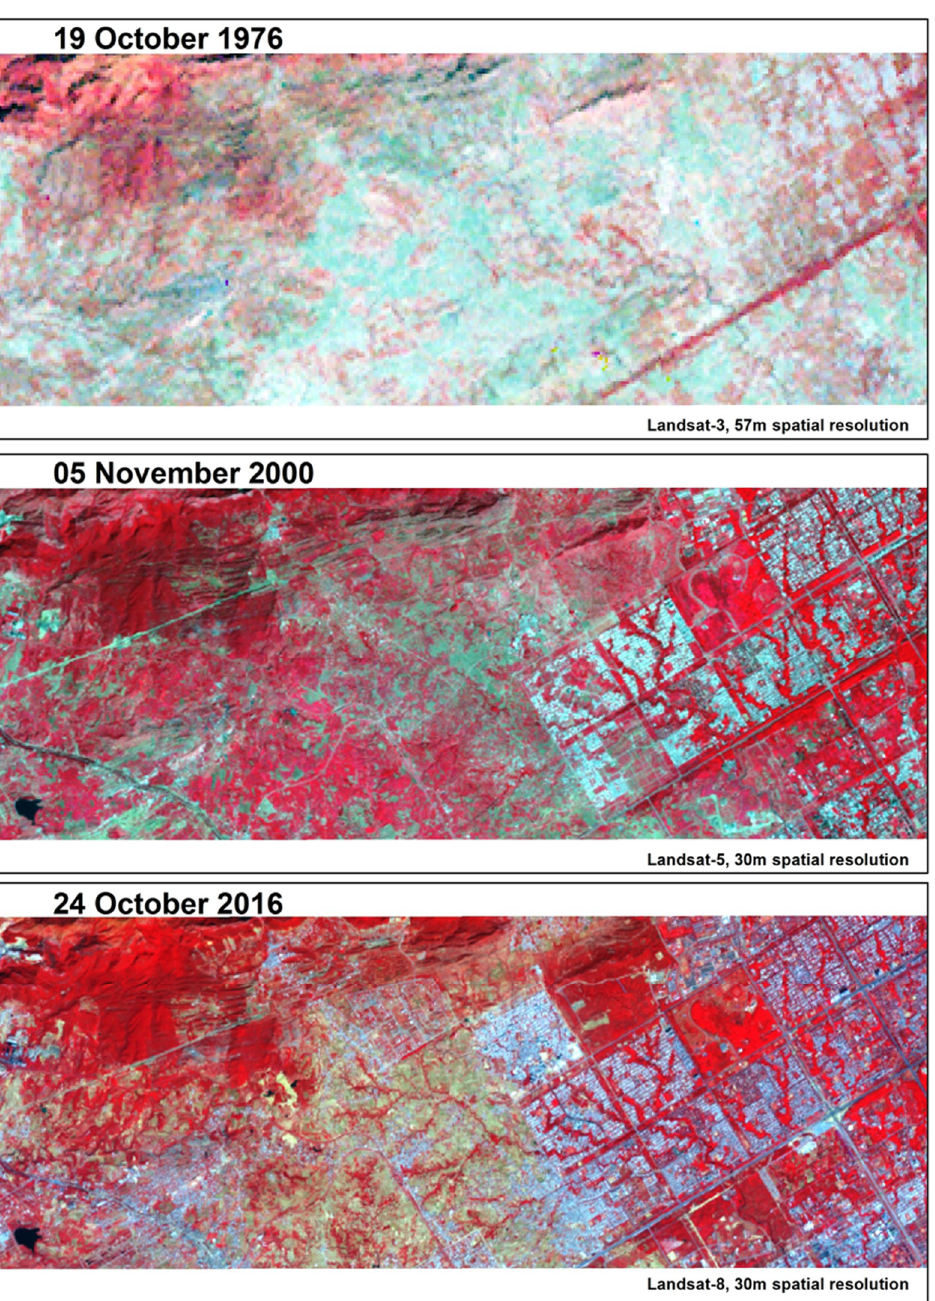
Figure 7. Temporal Landsat satellite images of 1976, 2000, and 2016 in standard False Color Composite (FCC), illustrating an overall increase in built-up areas over the years in the ICT. The area of the ICT shown here represents the bounded box inset covering Zone I and Zone II partially in Figure 1.